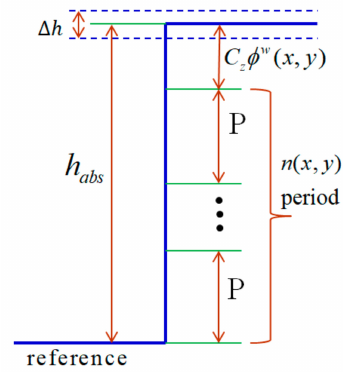
Figure 8. Illustration of fringe-order calculation using calibrated absolute